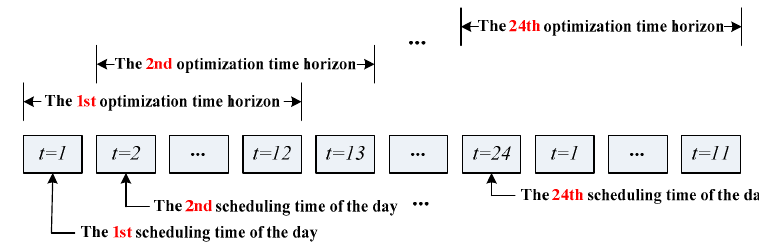
Figure 2. Procedure of the proposed stochastic Model Predictive Control (MPC).